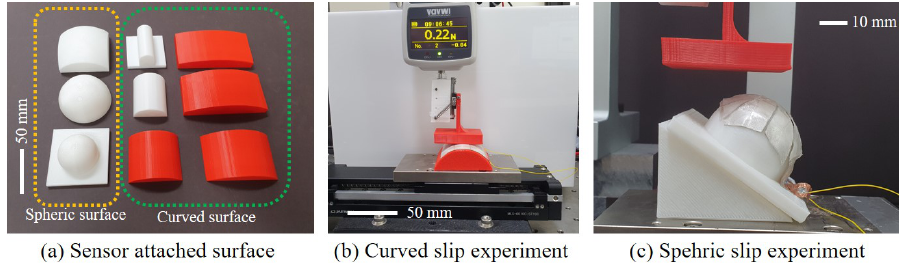
Figure 10. Curved and spheric